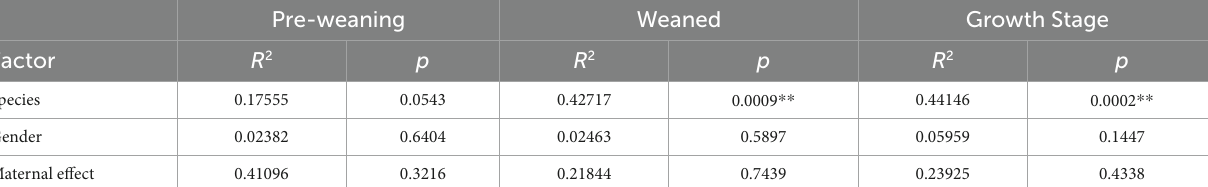
TABLE 3 Andonis results of the differential